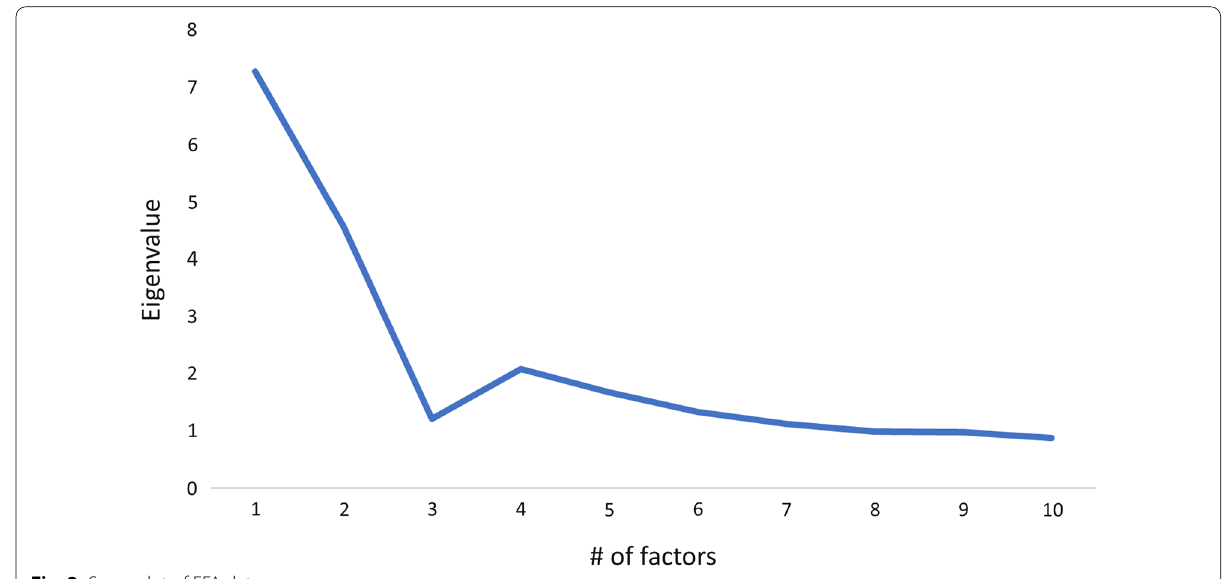
Fig. 2 Scree plot of EFA data